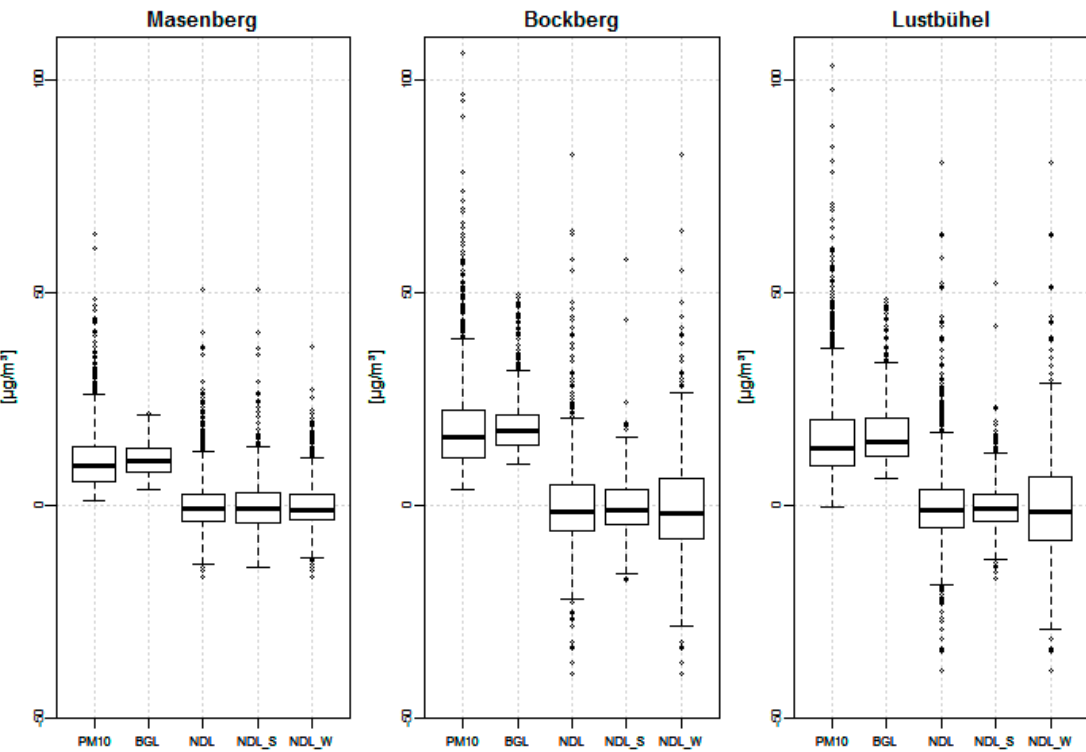
Figure 4. Boxplot of the daily mean PM 10 , the background loads (BGL) calculated based on the mean as well as the net dust loads (NDL) for the whole years as well as for the summer (NDL_S) and winter period (NDL_W) of the three potential background stations.